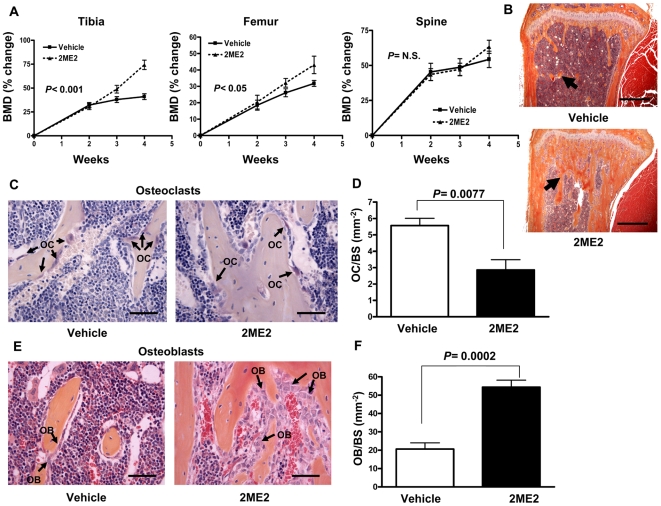
2ME2 increases bone density, inhibits osteoclasts and increases osteoblasts in normal bone unaffected by tumor.(A) Bone mineral density of the femur, tibia, and spine measured by DXA in mice treated ± 2ME2 (150 mg/kg). Results are expressed as the mean ± SEM % change in BMD (n = 10 per group). Statistical analysis by two-way ANOVA with a Bonferroni post-test at week 4. (B) Representative histology of tibias from mice ± 2ME2 (150 mg/kg) for 4 weeks. Trabecular bone is indicated by arrows. Scale bar equal to 500 µm. (C) Representative TRAP staining of bone histology of the proximal tibias from the mice. TRAP+ osteoclasts (OC) are indicated by arrows. Scale bar is equal to 50 µm. (D) Osteoclast number was measured in the distal femur and proximal tibia at 200×magnification on TRAP stained slides. Results are expressed as the number of osteoclasts (OC) per mm2 bone surface (BS). (E) Representative H&E stained bone histology of the proximal tibias from mice treated ± 2ME2 (150 mg/kg). Osteoblasts (OB) indicated by arrows. Scale bar is equal to 50 µm. (F) Osteoblast number was measured below the primary spongiosa in the distal femur and proximal tibia at 200×magnification on H&E stained slides. Results are expressed as the number of osteoblasts (OB) per mm2 bone surface (BS).